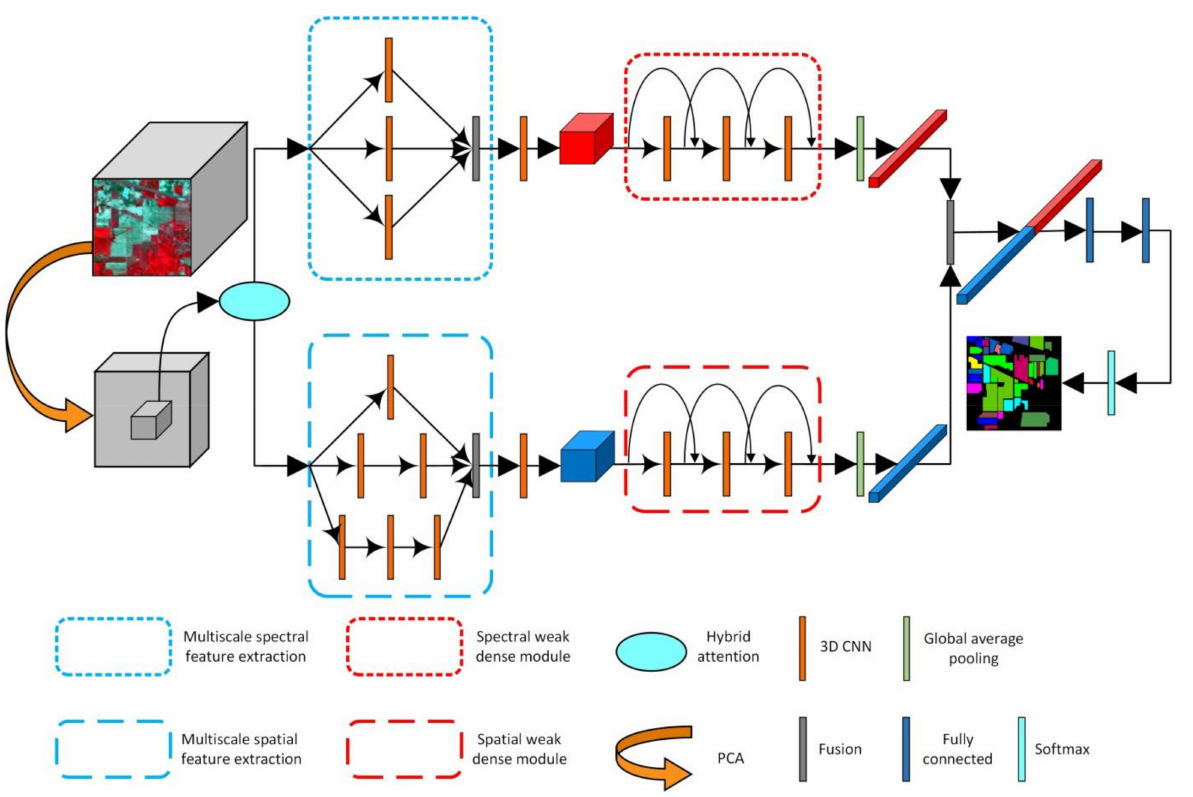
Figure 4. Overall network